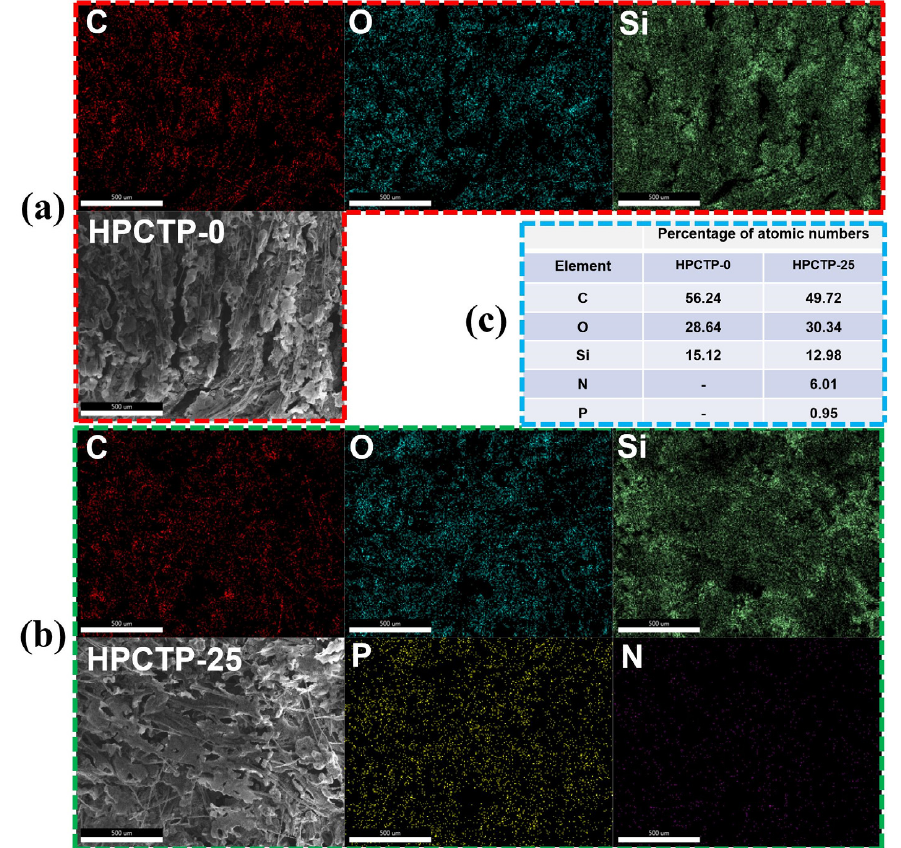
Figure 9. Elemental analysis of the char layer of the sample after ablation: Mapping images on the surface of char layer of ( a ) HPCTP-0; ( b ) HPCTP-25; ( c ) the relative content of elements related to the EDS on the surface of the char layer.